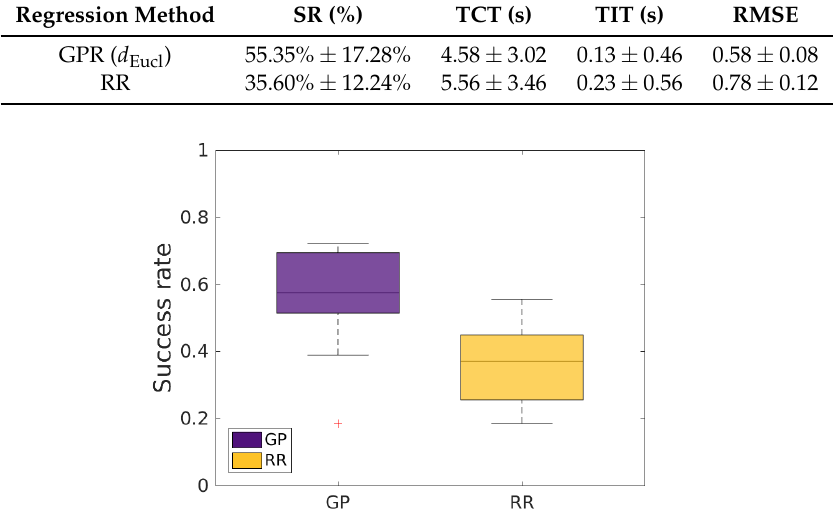
Figure 6. Comparison of the success rate (SR) of Gaussian process regression (GPR) and ridge regression